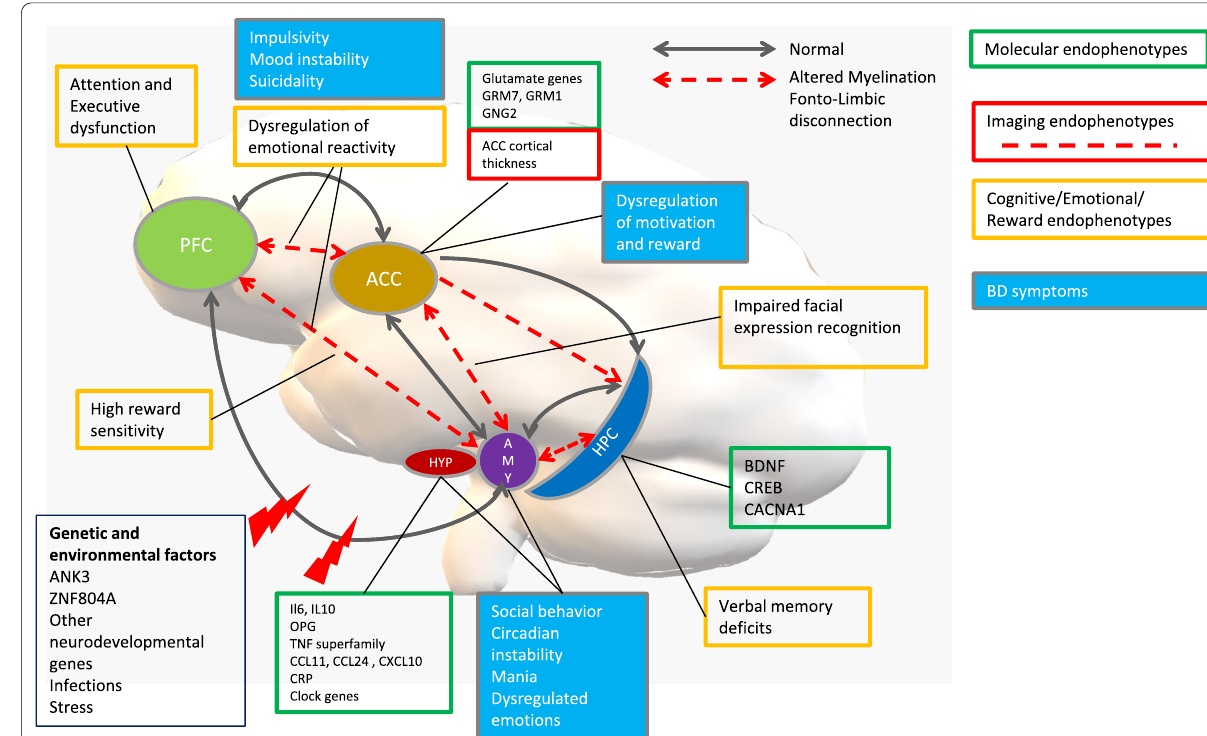
Fig. 1 Putative endophenotypes for bipolar disorder. Heuristic model to link the putative endophenotypes (molecular, imaging and cognitive) to distal phenotypes like BD symptoms. Major findings in endophenotype research suggest a developmental origin of BD. This figure shows as the interplay between environmental risk factors like stress and infections, and the genetic susceptibility of different systems like immune, circadian and glutamatergic systems could shape a vulnerable brain on which new stressors are added in young adulthood which favours the onset and the progression of the disorder. ACC anterior cingulate cortex, Calcium Voltage-Gated Channel Subunit Alpha1, ANK3 Ankyrin 3, AMY amygdala, BDNF Brain Derived Neurotrophic Factor, CACNA1 Calcium Voltage-Gated Channel Subunit Alpha1, CCL11 C-C Motif Chemokine Ligand 11, CCL24 C-C Motif Chemokine Ligand 24, CXCL10 C-X-C Motif Chemokine Ligand 10, CRP C-Reactive Protein, CREB CREB Binding Protein, GRM1 Glutamate Metabotropic Receptor 1, GRM7 Glutamate Metabotropic Receptor 7, GNG2 G Protein Subunit Gamma 2, HPC hippocampus, HYP hypothalamus, IL6 Interleukin 6, IL10 Interleukin 10, OPG Osteoprotegerin, PFC prefrontal cortex, TNF Tumor Necrosis Factor, ZNF804A Zinc Finger Protein